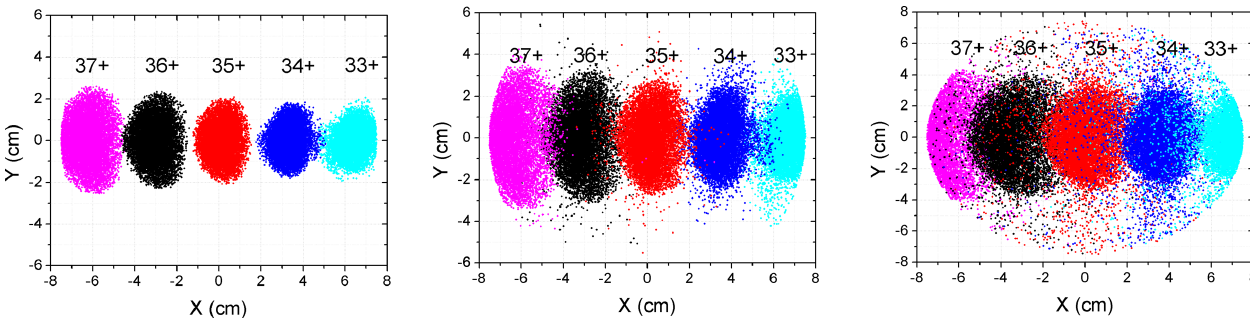
FIG. 10. Simulated particle distributions of different charge states at the end of CSS under space charge compensation degrees of 70% (left), 50% (middle) and 30%